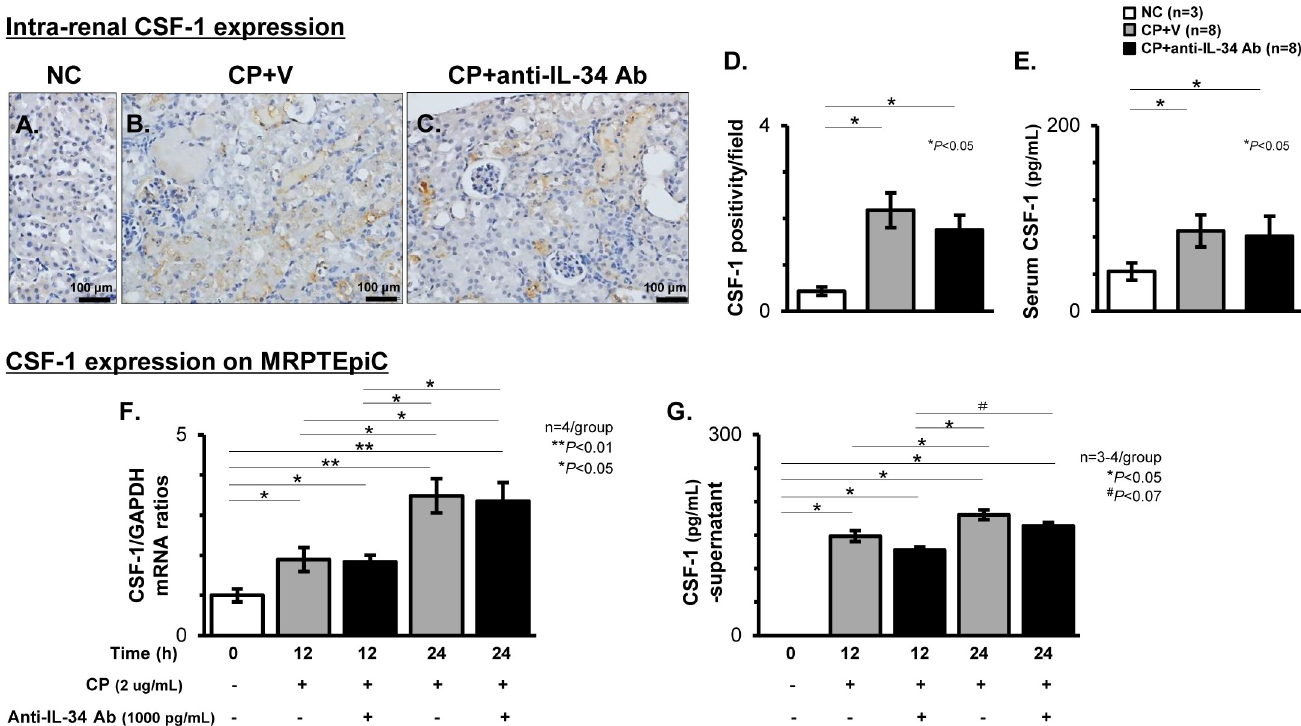
Fig 9. Expression of CSF-1 in CP-N mice and CP-stimulated MRPTEpiC. Representative photos of the intra-renal CSF-1 expression on TECs identified by immunostaining among the NC ( A ), CP+V ( B ), and CP+anti-IL-34 Ab ( C ) groups of mice. Original magnification, 400 × . Graph of CSF-1 positivity per field among the study groups ( D ). The serum CSF-1 levels evaluated by ELISA among the study groups ( E ). Real-time RT-PCR for CSF-1 in CP-stimulated MRPTEpiC with or without anti-IL-34 Ab treatment for 0 to 24 h ( F ). Values were normalized to the GAPDH transcript, and are expressed as the relative ratio. The CSF-1 protein levels evaluated by ELISA in the culture supernatants of MRPTEpiC after CP stimulation with or without anti-IL-34 Ab treatment for 0 to 24 h ( G ). Data are expressed as the mean ± SEM. The Mann-Whitney U test was used for statistical analysis.